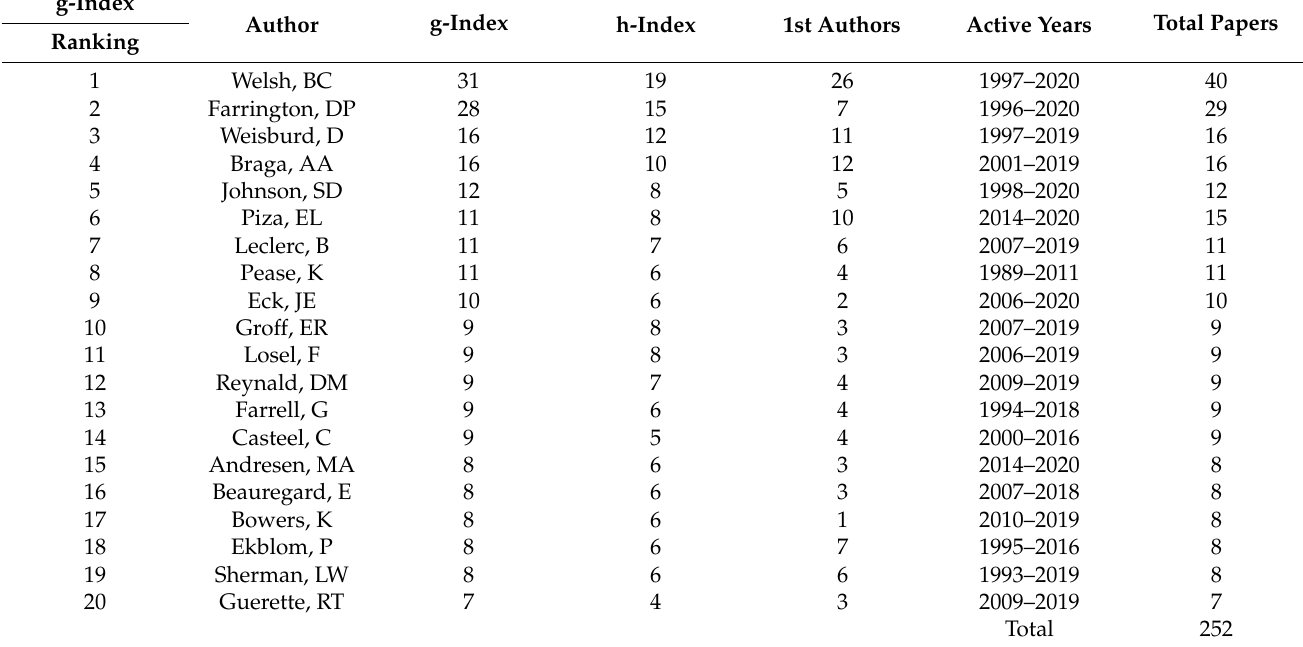
Table 2. The top 20 most influential